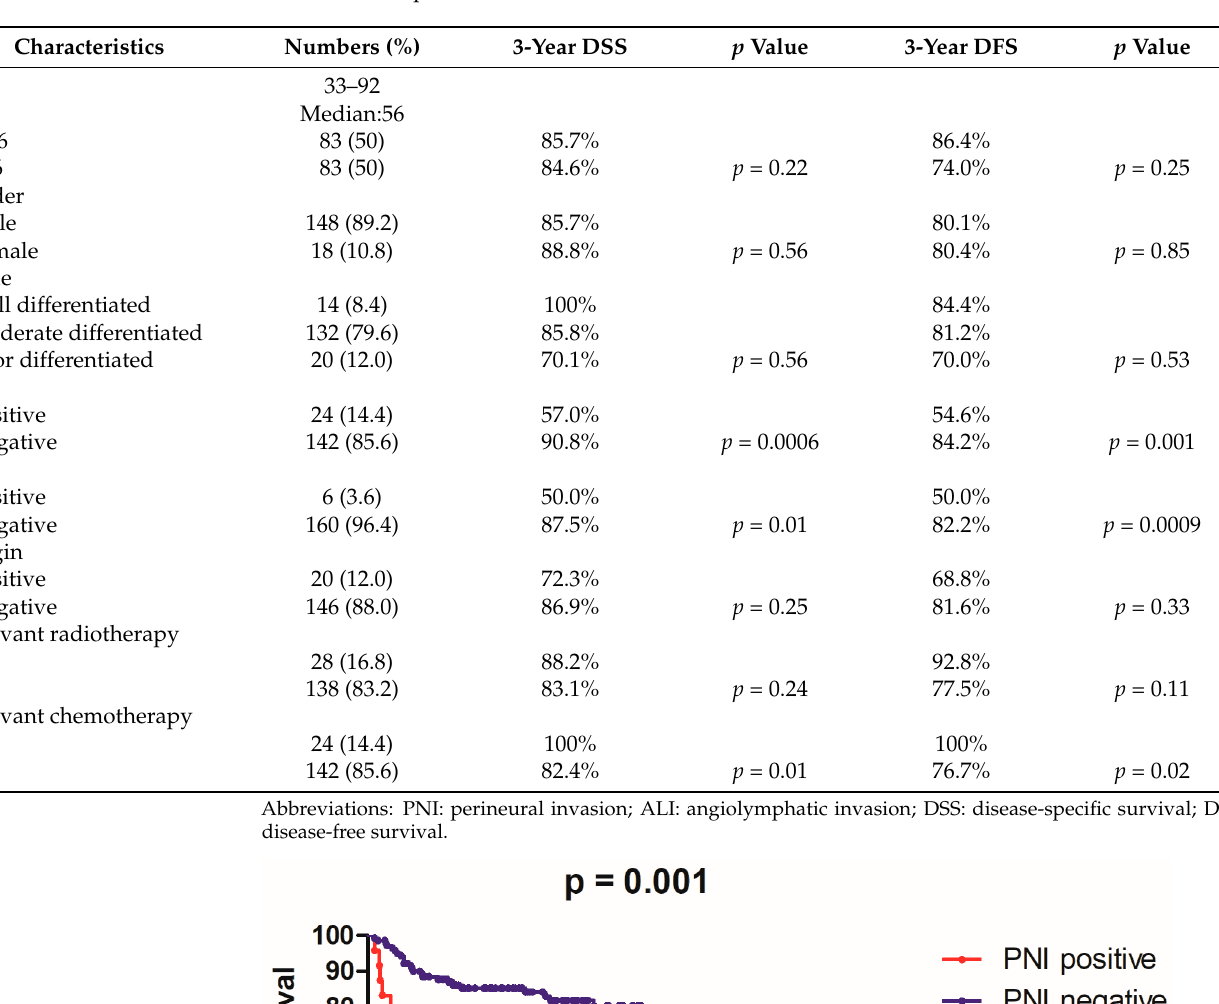
Table 1. Patients’ characteristics and univariate analysis for disease-specific survival and disease-free survival in 166 patients with T2N0 OSCC.